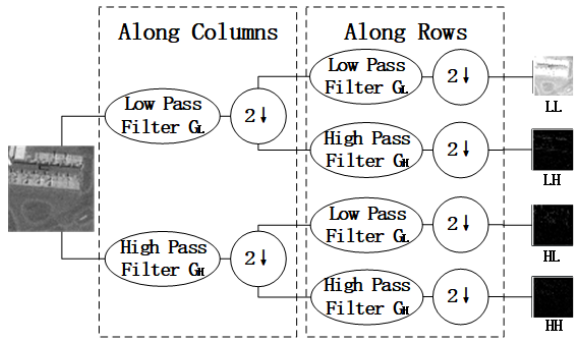
Figure 2. The flowchart of Haar wavelet